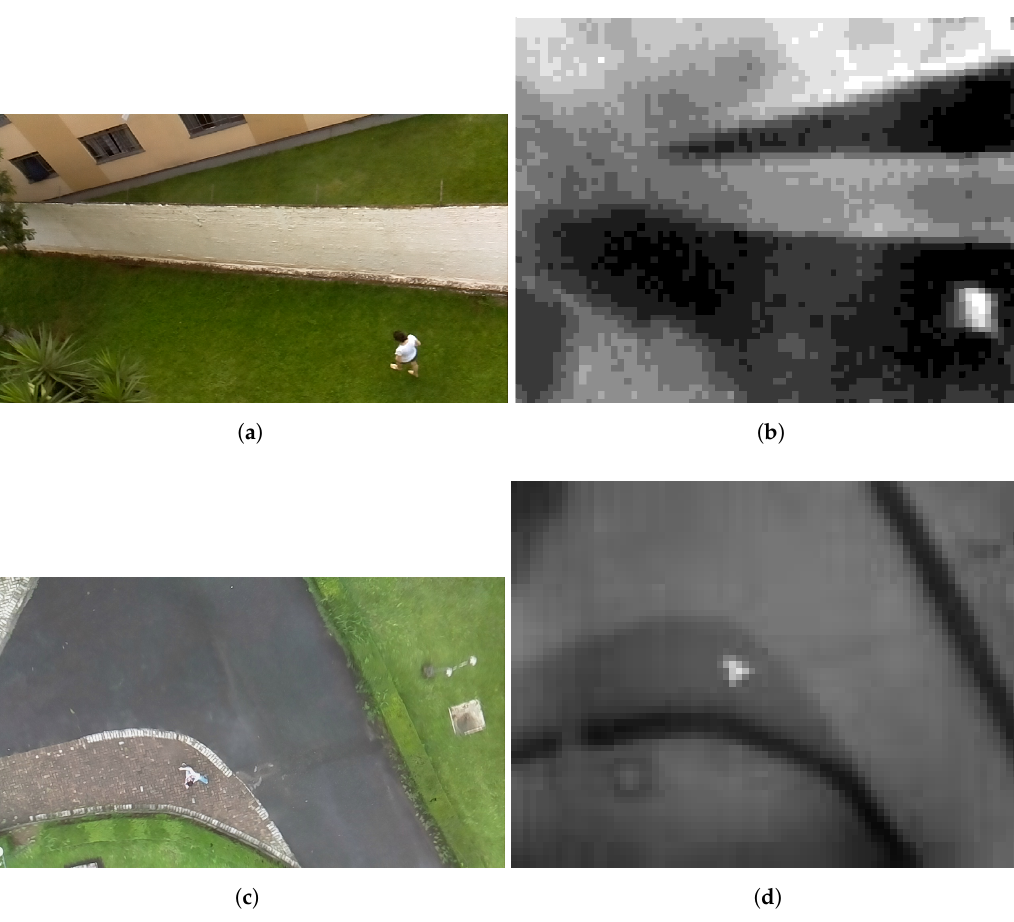
Figure 5. Images captured during the PRS experiments. Subfigures ( a , c ) are RGB images captured by the Raspicam; subfigures ( b , d ) are thermal images captured by the FLIR camera. We collected the images ( a , b ) on the top of a building, whereas we collected ( c , d ) during a quad-rotor UAV